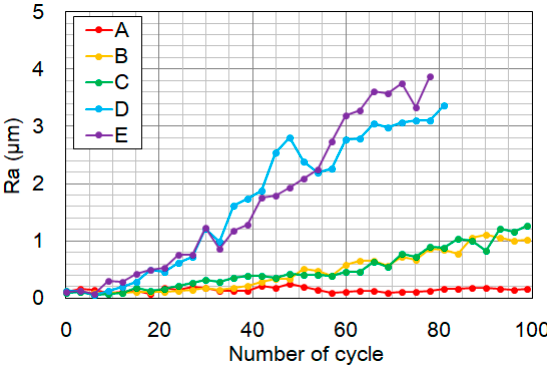
Figure 9. Change in Ra with number of cycle in the 100-cycle test with 1 mm air gap.